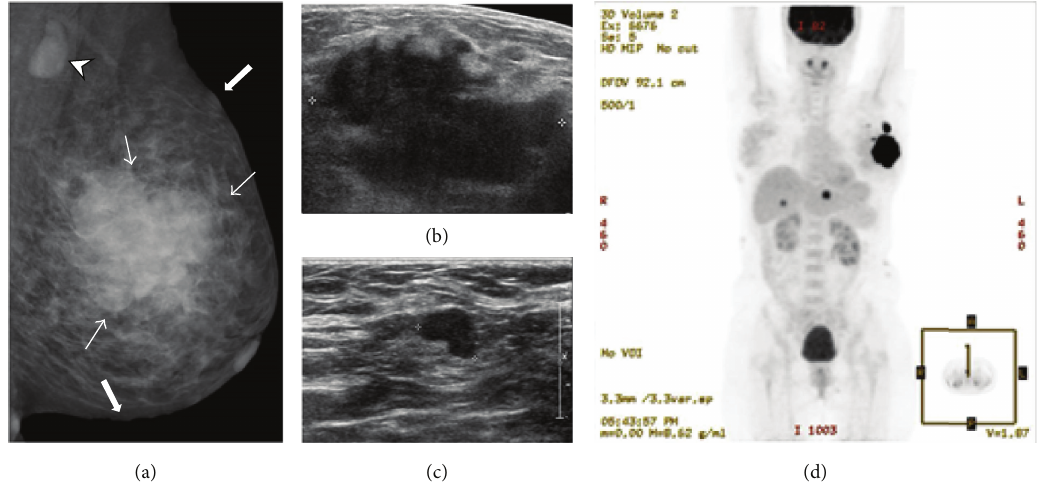
Figure 2: Left mediolateral oblique mammography shows an irregular hyperdense mass with indistinct margin (thin arrow) and axillary lymphadenopathy (arrowhead). Additionally, skin undulation is seen, indicating presence of cutaneous neurofibromas (thick arrow). Ultrasonography shows a large, hypoechoic, irregular mass with angular margin in the left breast (b) and multiple metastatic lymph nodes in the left axilla (c). PET-CT shows hepatic metastasis